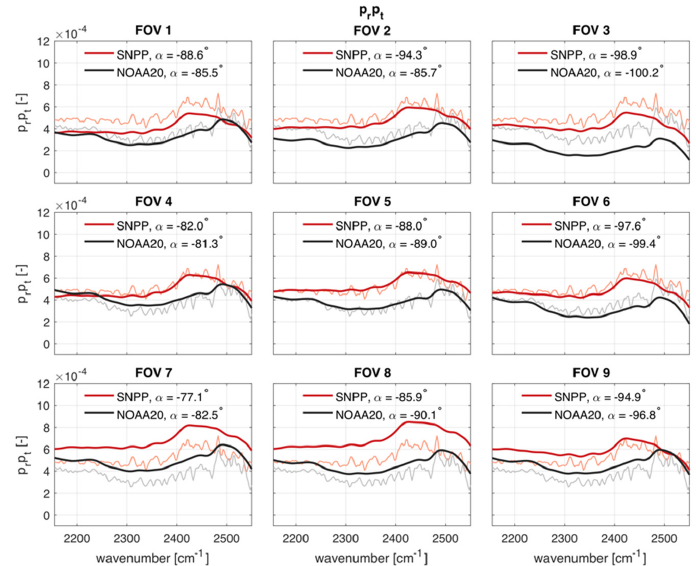
Figure 16. Combined scene select mirror and sensor polarization ( p r p t ) and sensor polarization angle derived from the shortwave pitch maneuver data. SNPP is shown in red, and NOAA-20 is shown in black. The lighter weight lines are the derived p r p t values for the average over all fields of view, with no noise filtering or spectral averaging applied.